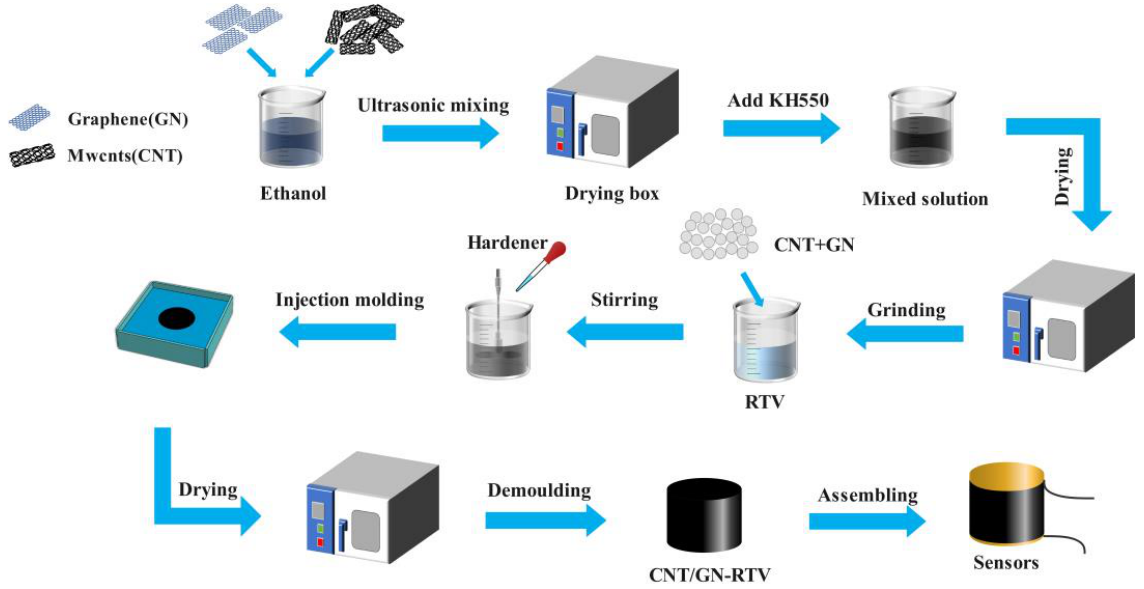
Figure 2. The example flowchart for the manufacturing of CNT/GN-RTV polymers.